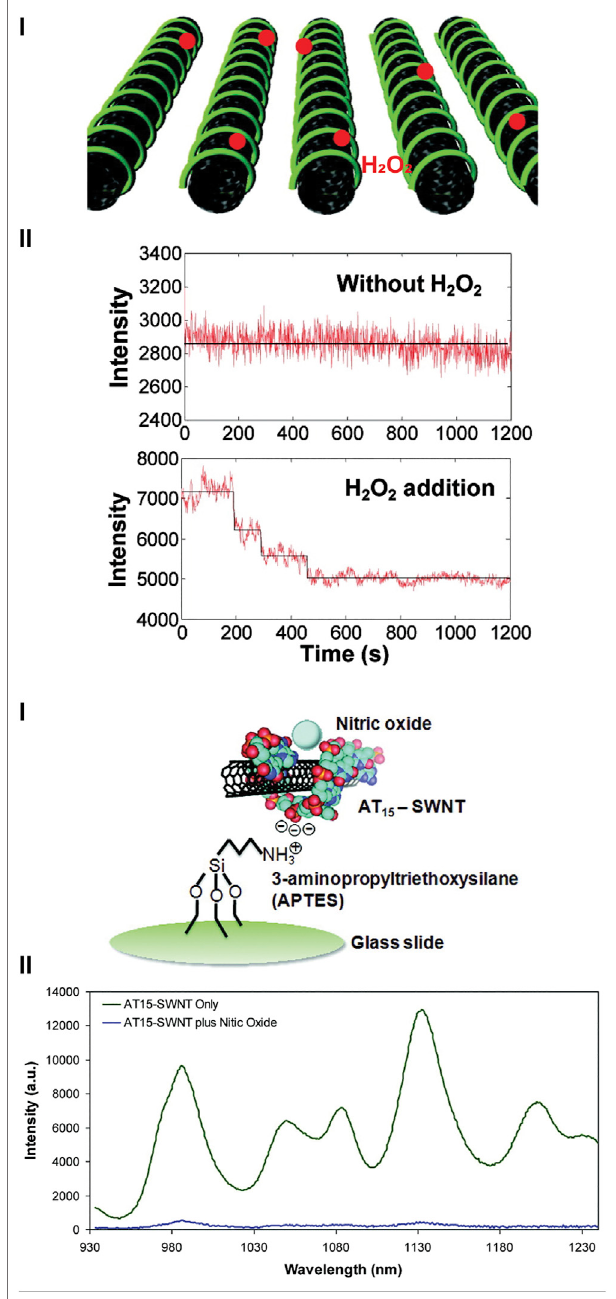
FIGURE 4 | Single walled carbon nanotubes (SWCNTs) for detecting ROS and RNS. [(A), i] . SWCNTs coated with collagen for the detection of H 2 O 2 , where the presence of H 2 O 2 changes the fl uorescence emission. Reprinted (adapted) with permission from Kim et al. (2011). ACS Nano 2011, 5, 10, 7,848 – 7,857. Copyright 2011 American Chemical Society. (B) (cid:129) SWCNTsusedforthedetectionofNO . [(B),i] .DNAstrandd(AT) 15 wasused to coat SWCNTs and immobilized onto an amine-functionalized glass slide. [(B), ii] . Fluorescence spectrum of d(AT) 15 -SWCNTs in the absence and (cid:129) presence of NO . Reprinted (adapted) with permission from Zhang et al. (2011). J. Am. Chem. Soc. 2011, 133, 3, 567 – 581. Copyright 2010 American Chemical